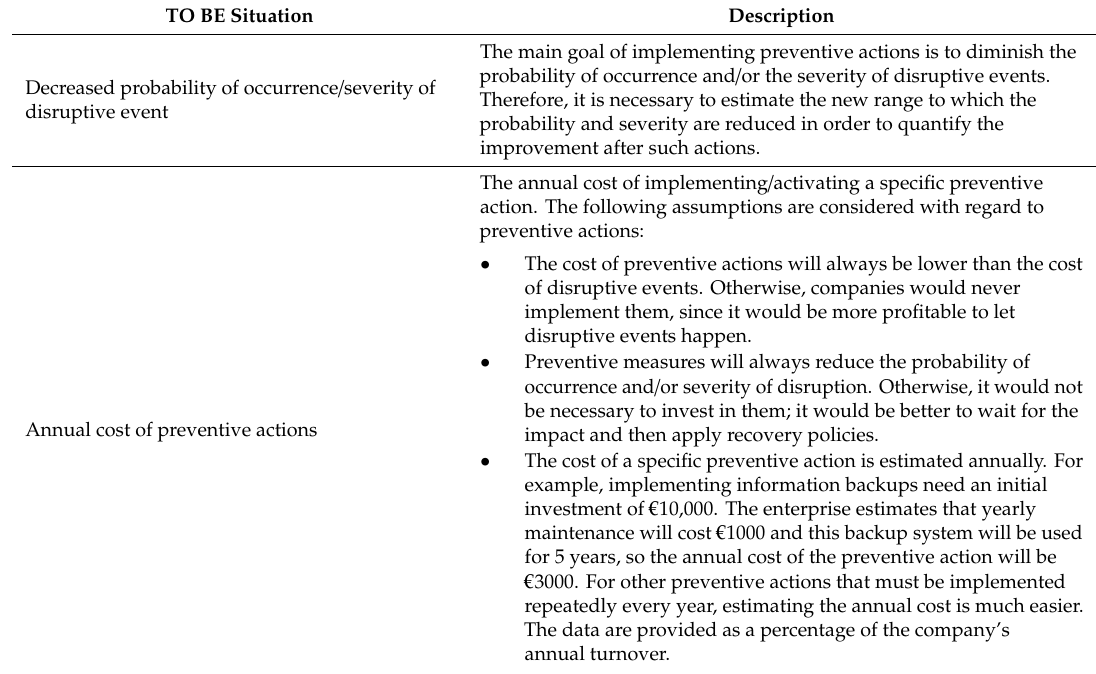
Table 4. Input data required to analyse future (TO BE model) preparedness capacity.